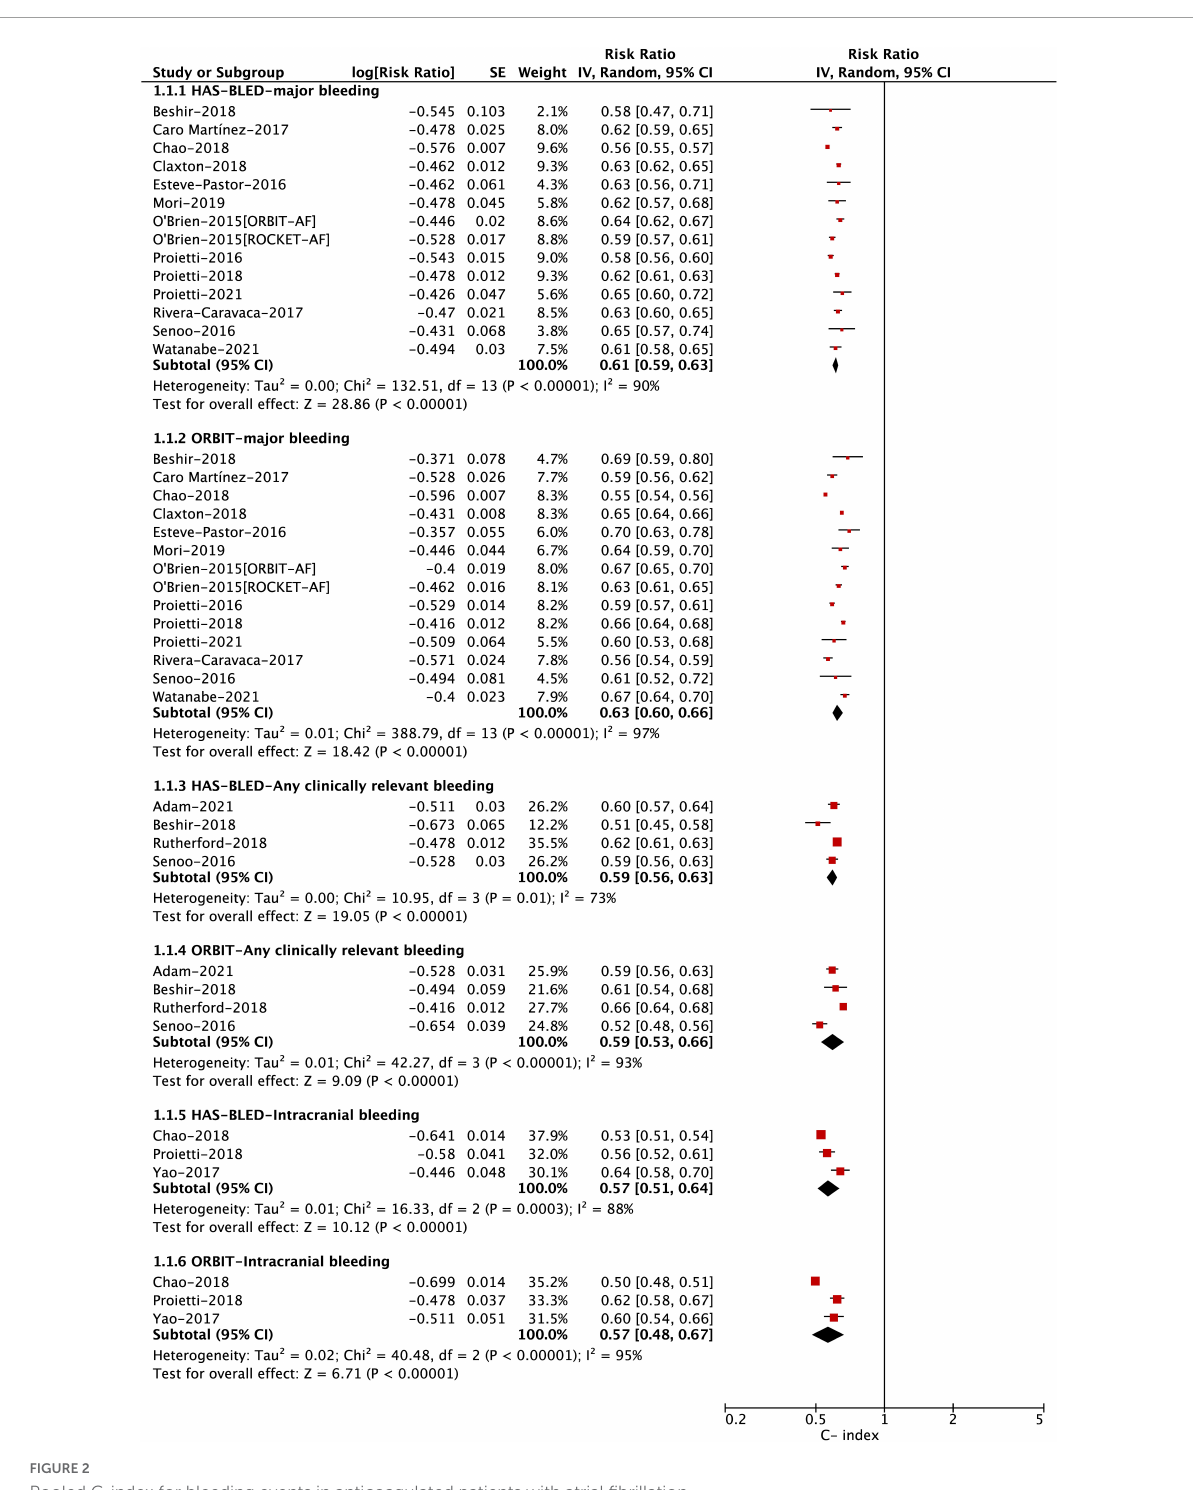
FIGURE2 Pooled C-index for bleeding events in anticoagulated patients with atrial fibrillation.